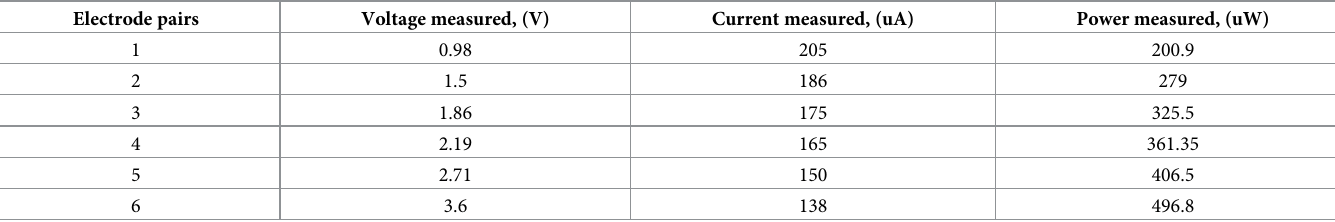
Table 5. The magnitude of voltage and current harvested. Electrode pairs Voltage measured, (V) Current measured, (uA) Power measured,